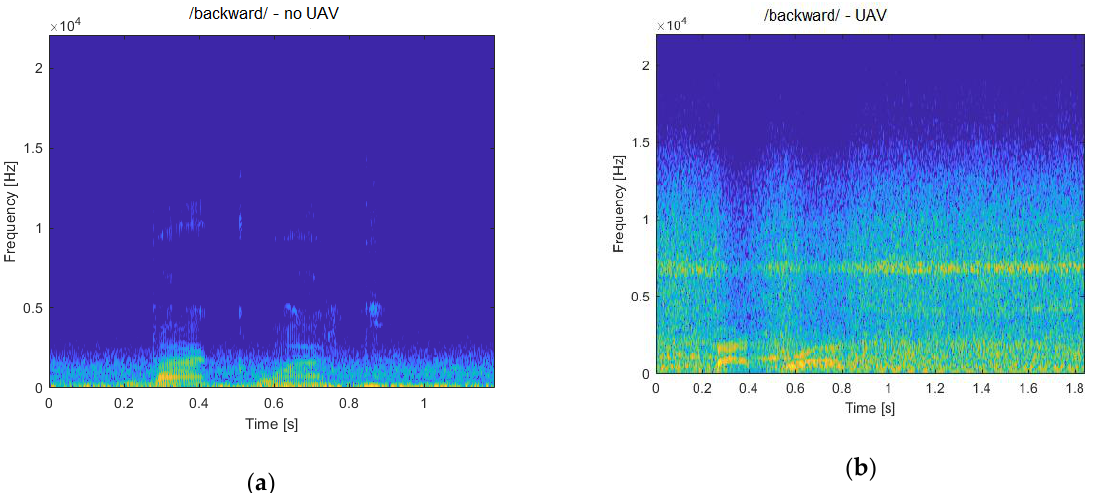
Figure 5. Time–frequency analysis of the /backward/ speech command: ( a ) in the absence of the UAV, ( b ) in the presence of the UAV hovering at a height of 1.8 m in laboratory conditions.